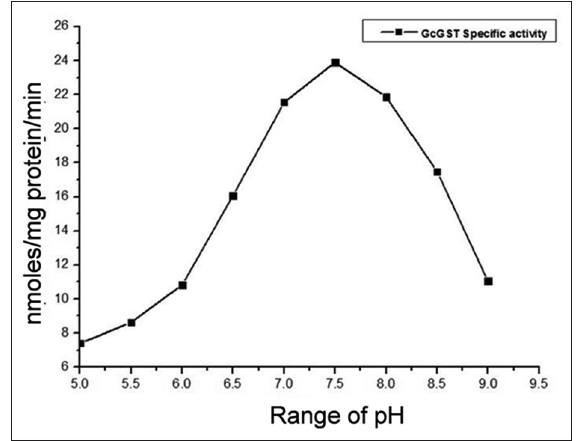
Figure-3: The pH stability of the purified glutathione S-transferase (GST) proteins from Gastrothylax crumenifer in 100 mM sodium phosphate buffer having different pH (5.0-9.0). Purified GSTs (1 mg) were incubated in 1 ml of phosphate buffer solution at 4°C for 30 min.